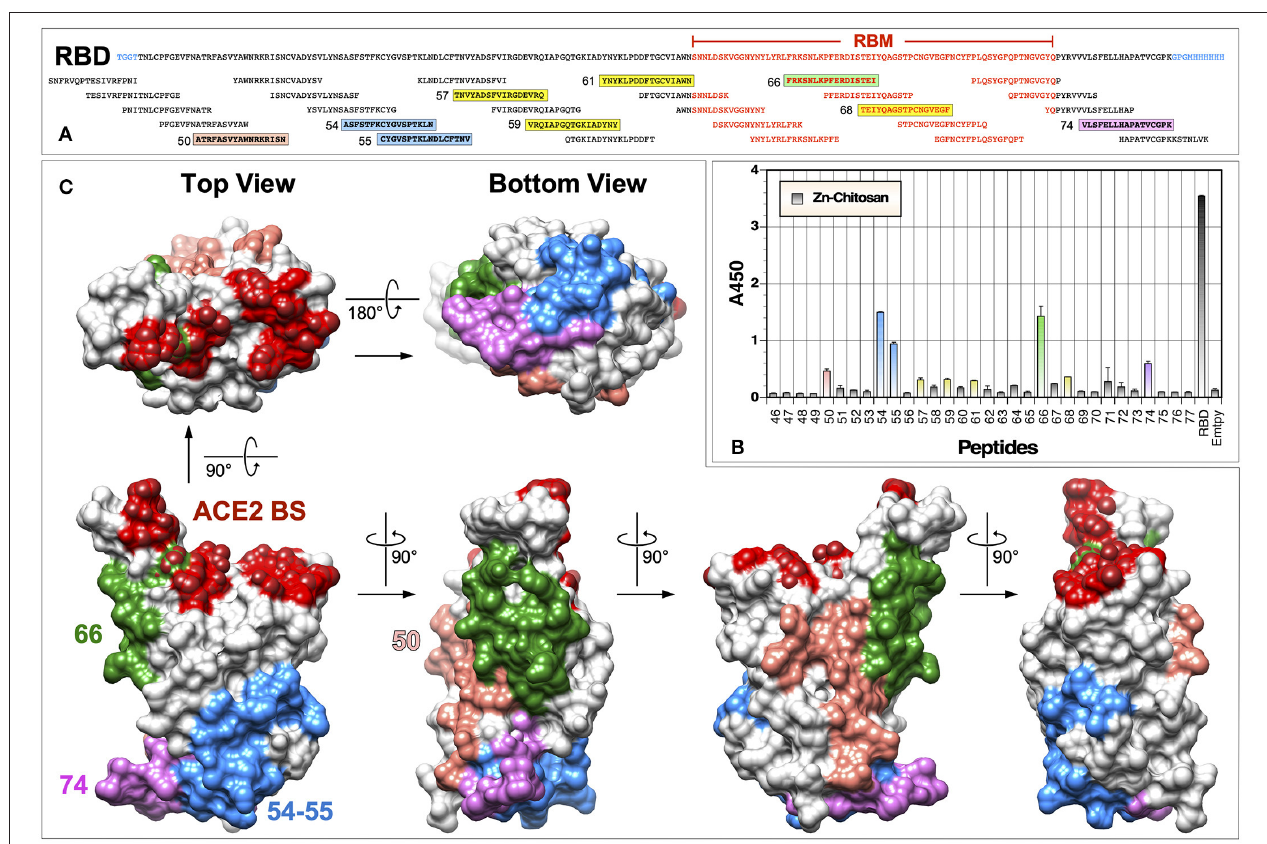
FIGURE 7 | Identification of immunogenic epitopes using overlapping peptides. (A) Sequence of the RBD and overlapping peptides (obtained from BEI Resources) used in ELISA. Amino acid residues located within the RBM are indicated in red text. Immunogenic epitopes are highlighted in colored boxes. (B) ELISA was done using serum samples (1:300 dilution) from mice immunized with Zn-chitosan, collected 6 weeks after the third immunization. Two hundred nanograms of peptides were coated in each well. RBD was used as a positive control. A negative control without any peptides is indicated as “Empty.” No immunoreactive peptides were identified using serum samples from Alhydrogel or Adju-Phos groups. Peptide numbers represent those from the 181-peptide array of the S protein. (C) Locations of the five most immunogenic linear epitopes are mapped onto the RBD structure (PDB: